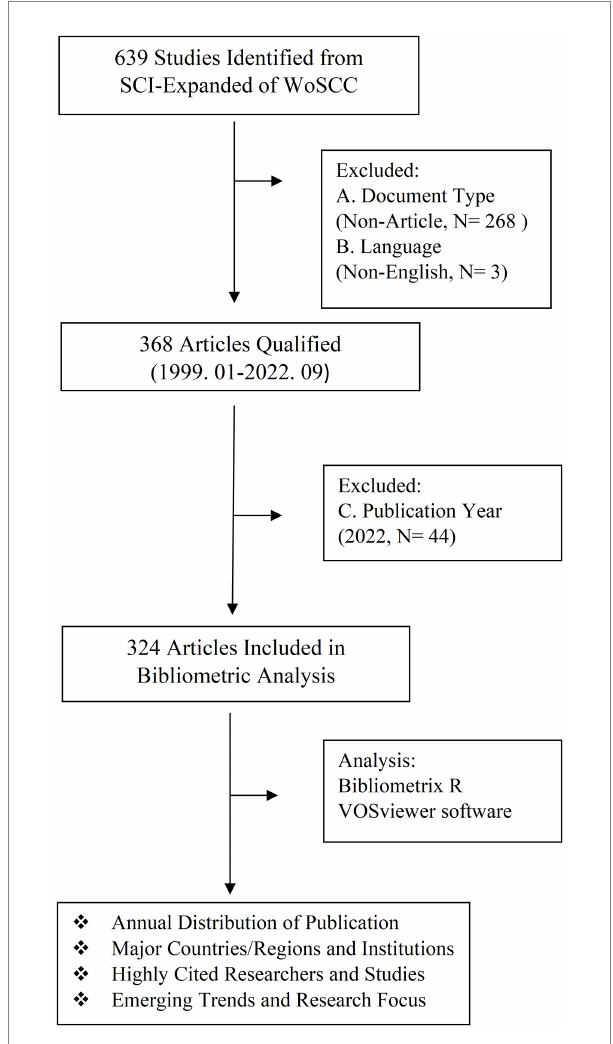
FIGURE 1 Workflow diagram of the literature search and screening of articles about gut microbiota and